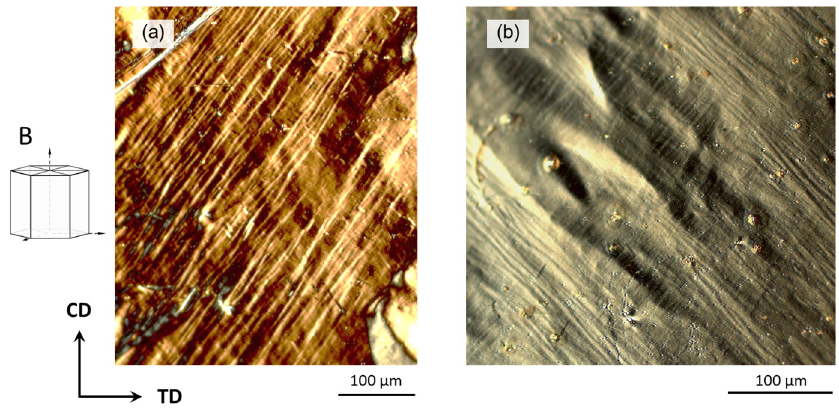
Figure 7. Optical micrographs (C ‐ DIC) of a prepolished CD ‐ LD side of a specimen with starting orientation B showing non ‐ rectilinear diagonal slip traces at an angle of ( a ) approximately 55° and ( b ) approximately 46° to TD.